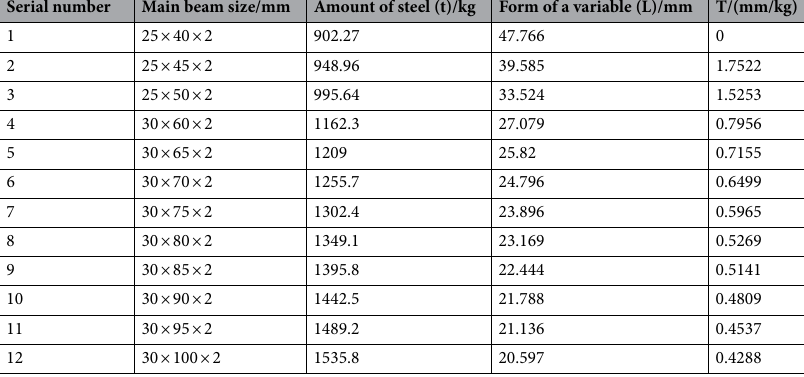
Table 5. The quantity and shape of steel used for different materials